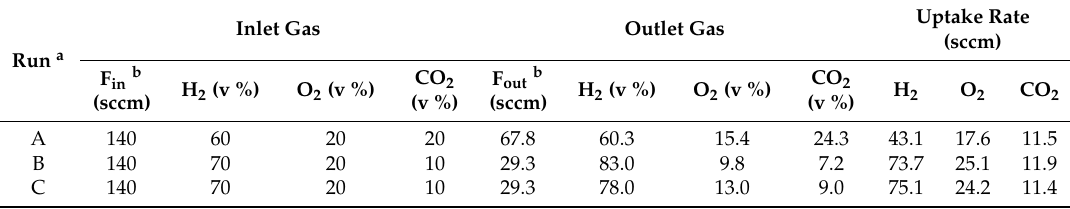
a . See Table 1 for the operation conditions; b . Gas flow rate (cm 3 min − 1 ) under standard conditions (273 K, 1 atm) and gas composition in volume % (=mole %).